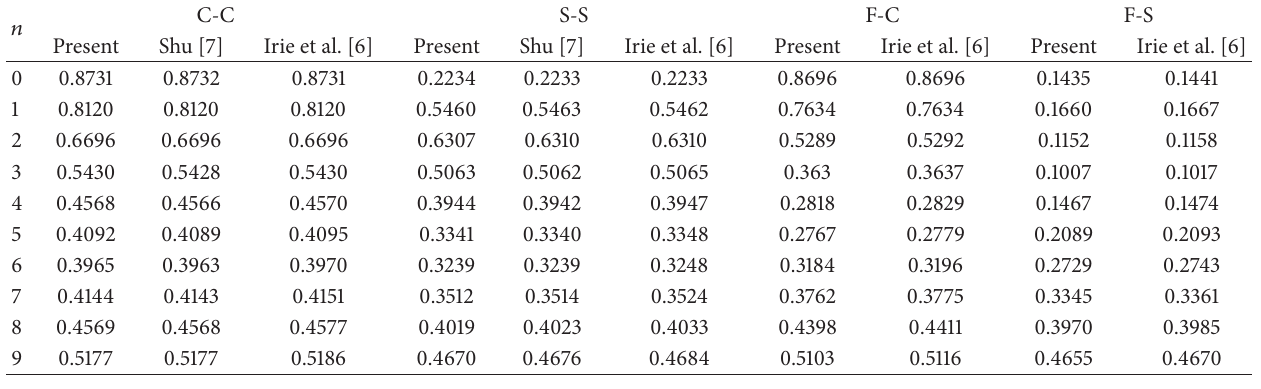
Table 1: Comparison of the natural frequency parameters under variable circumferential wave numbers ( 𝑎 = 45 ∘ , 𝐿 sin 𝑎/𝑅 2 = 0.5 , and ℎ/𝑅